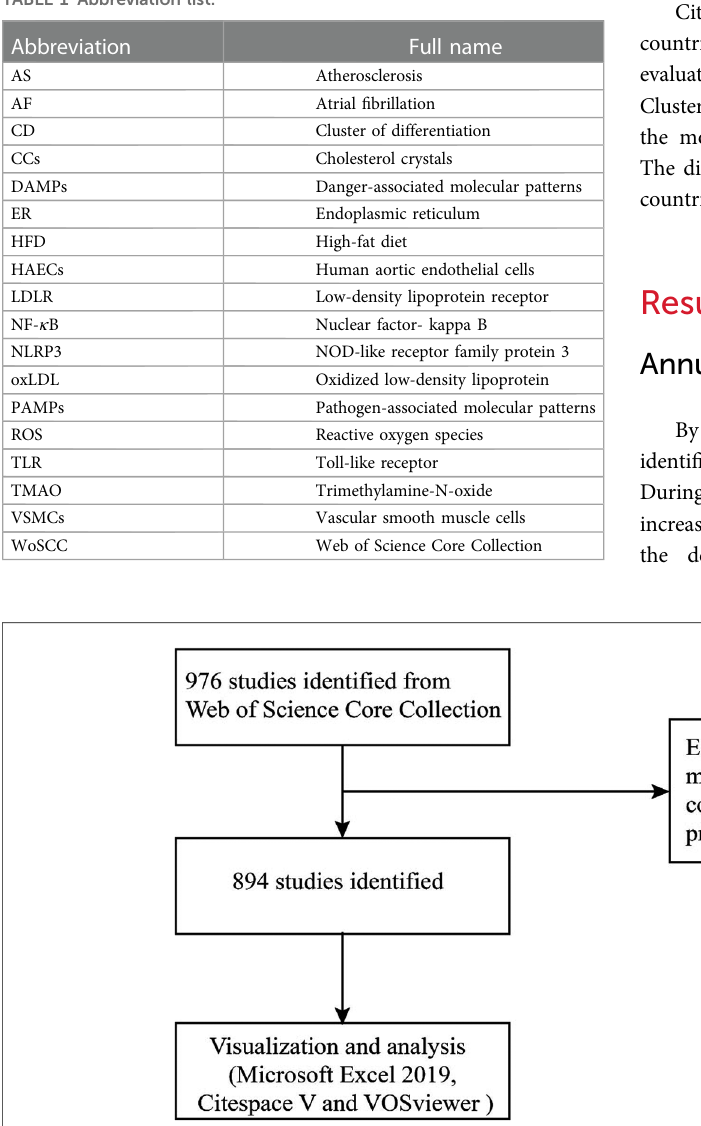
TABLE 1 Abbreviation